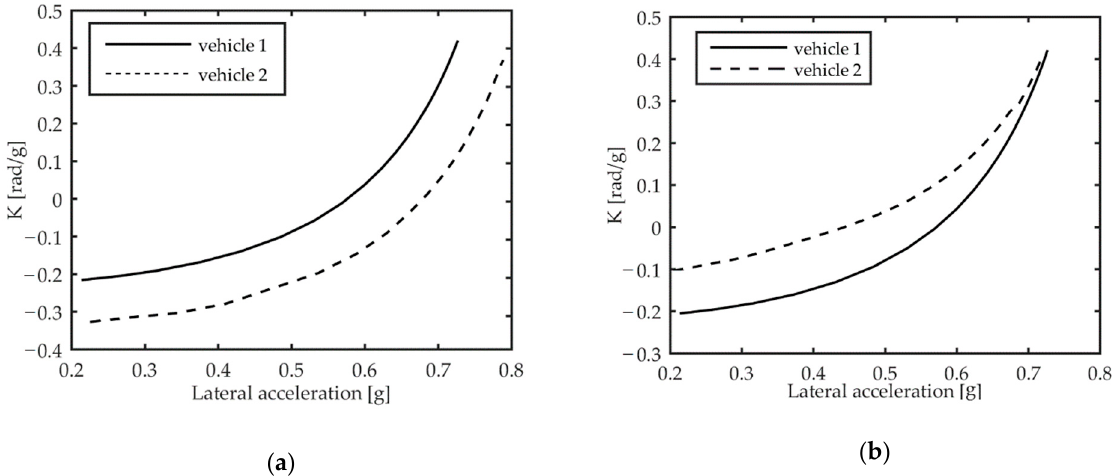
Figure 10. Understeer gradient estimated by implementing the CS test for vehicle 1 and for vehicle 2 in driving mode 1 ( a ) and in driving mode 2 ( b ).